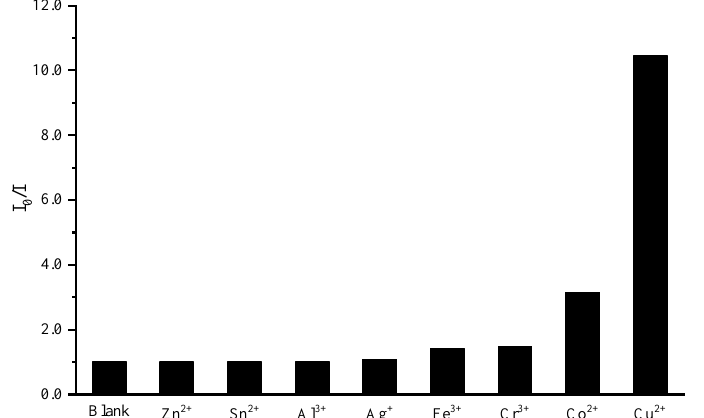
Figure 4. Fluorescence spectra of P(MMA-co-RB) (0.5 mg/mL in DMF, λ ex = 510 nm) with different cations (5 mM).